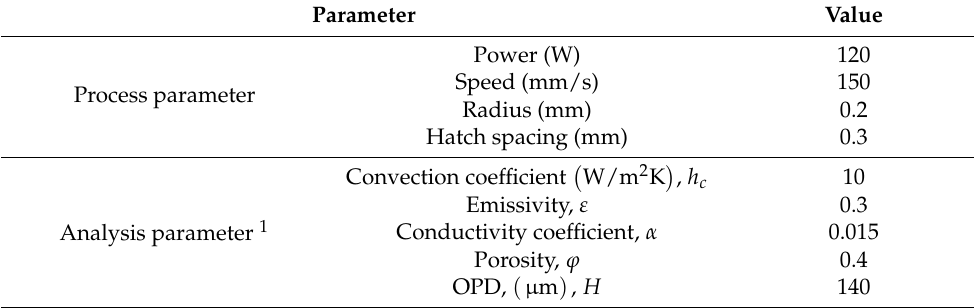
Table 1. Process and analysis parameters used in the analysis of Figure 2. Parameter Value Power (W) 120 Speed (mm/s) 150 Process parameter Radius (mm) 0.2 Hatch spacing (mm) 0.3 (cid:0) (cid:1) Convection coefficient W/m 2 K , h c Analysis parameter 1